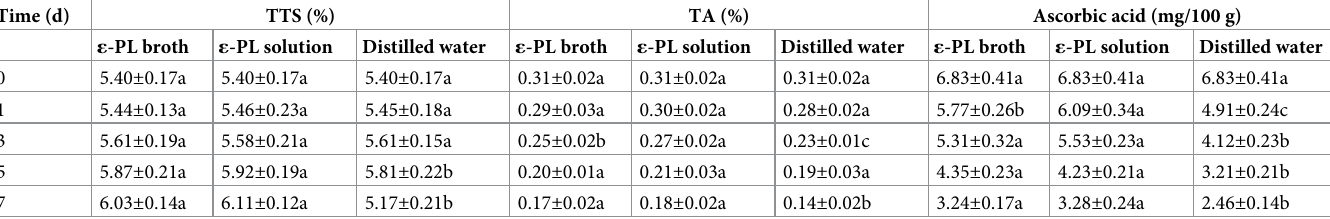
ε -PL concentration was 200 mg/L in the broth and ε -PL solution; values followed by the same letters within the same row for each quality parameter are not significantly different ( P < 0.05); data represents as the mean ± standard deviation (n =